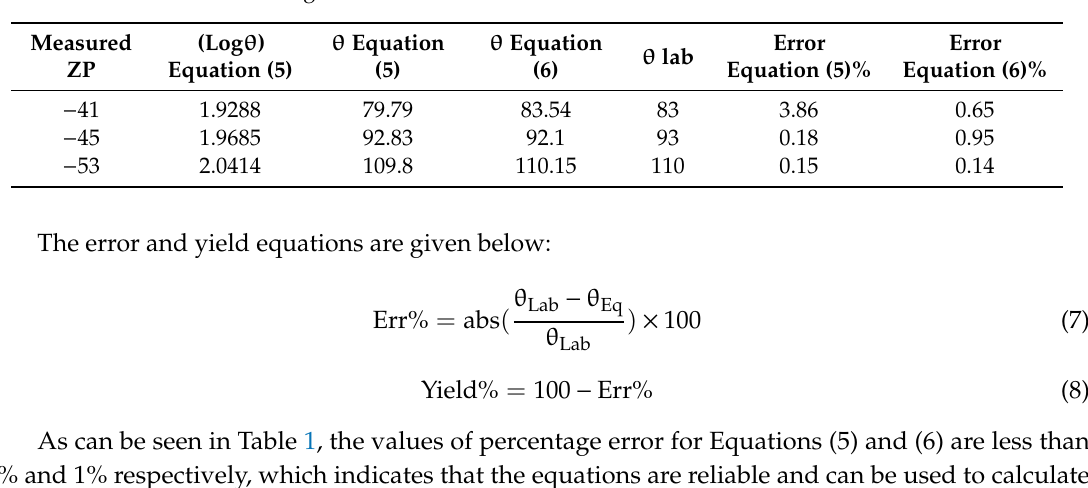
Table 1. The values of error associated with the contact angles calculated from each equation compared to the measured contact angles.